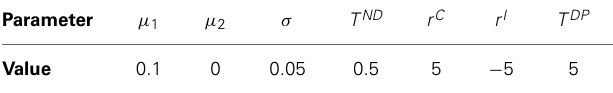
Table 2 | Task parameters used in the first example.